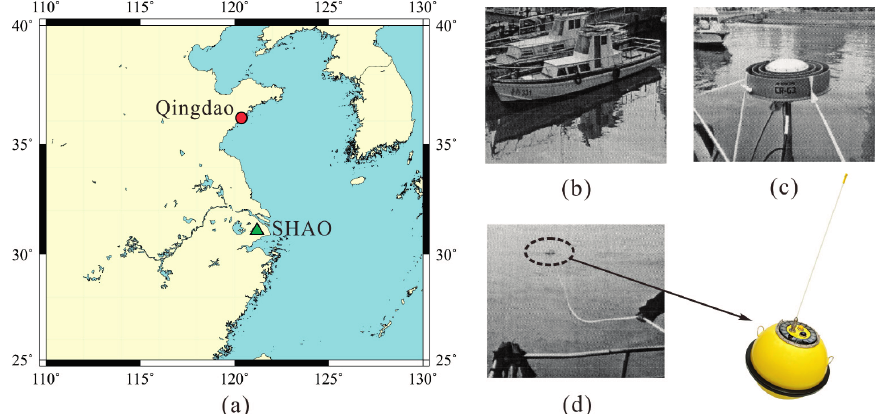
Figure 2. Field test area near Qingdao, China. ( a ) The location of Qingdao and the GPS reference station at Shanghai Astronomical Observatory (SHAO) of the International GNSS Service (IGS); ( b ) The small surveying vessel [22]; ( c ) The choke ring antenna [22]; ( d ) The DataWell Waverider MKIII wave gauge